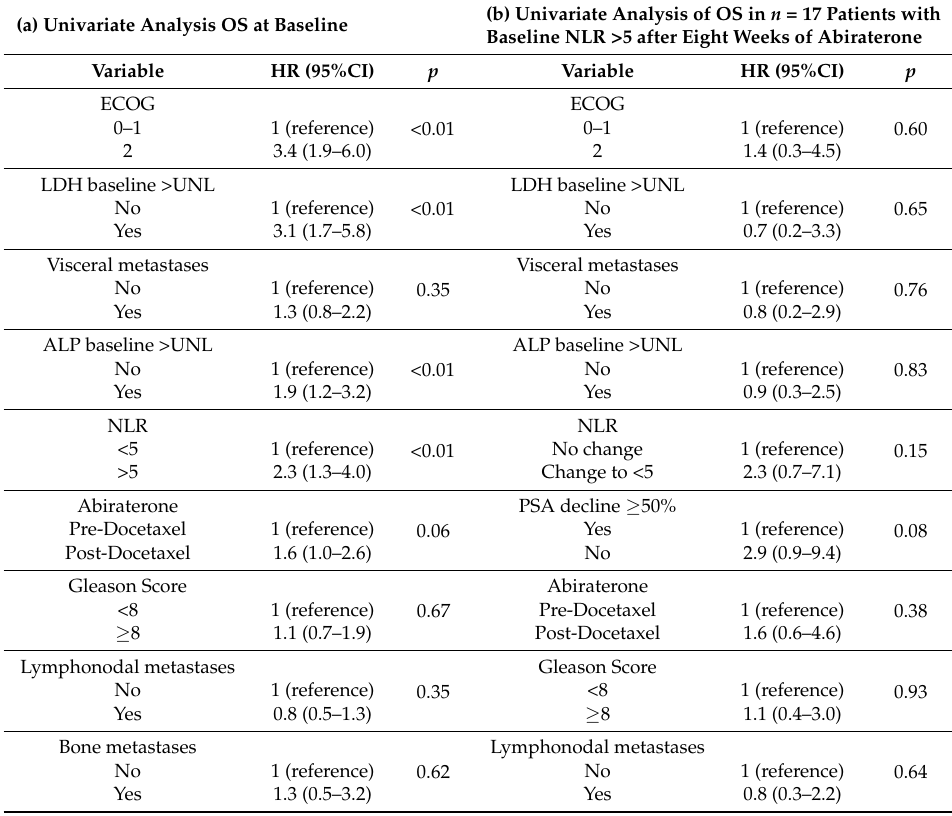
Table 3. Univariate analysis for baseline biomarkers for overall survival in (a) 96 mCRPC-patients prior to Abiraterone therapy and (b) in 17 patients with a baseline NLR >5 after eight weeks of